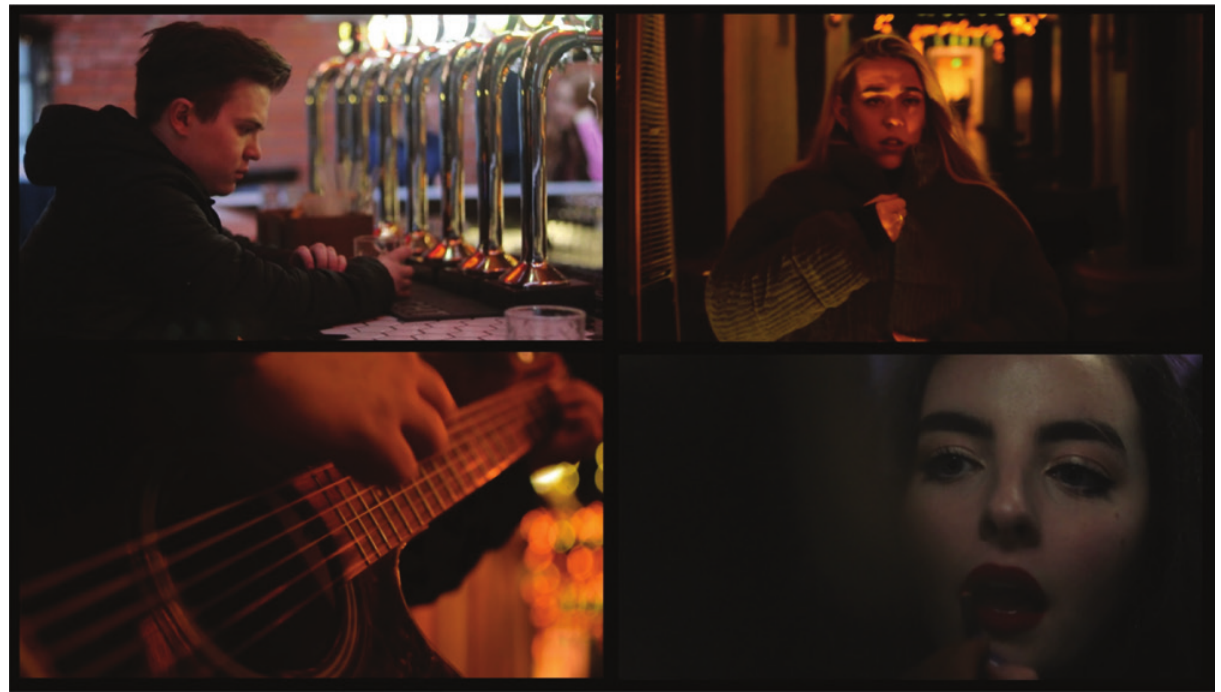
Figure 2. Various shots from Seen in Passing (Grace Bingham, 2019): man waits at the bar; waitress leaves; busker plays guitar; woman applying